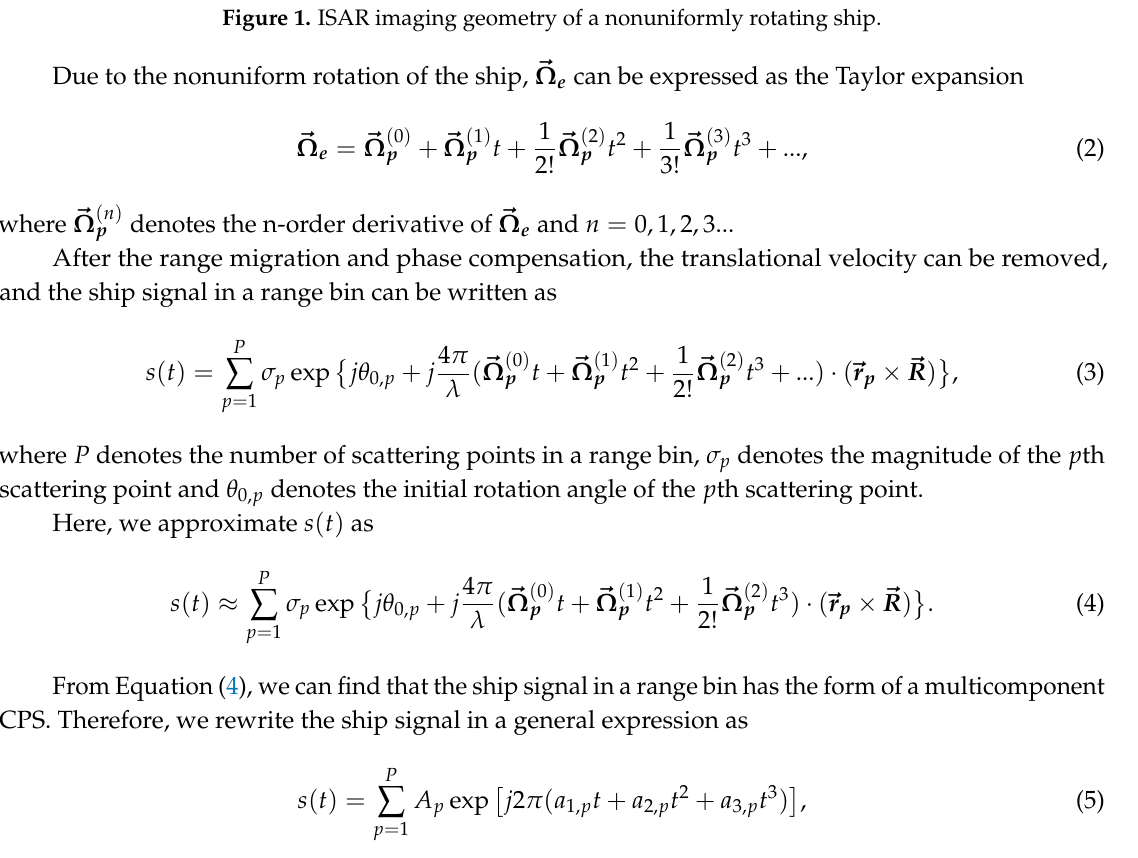
Figure 1. ISAR imaging geometry of a nonuniformly rotating